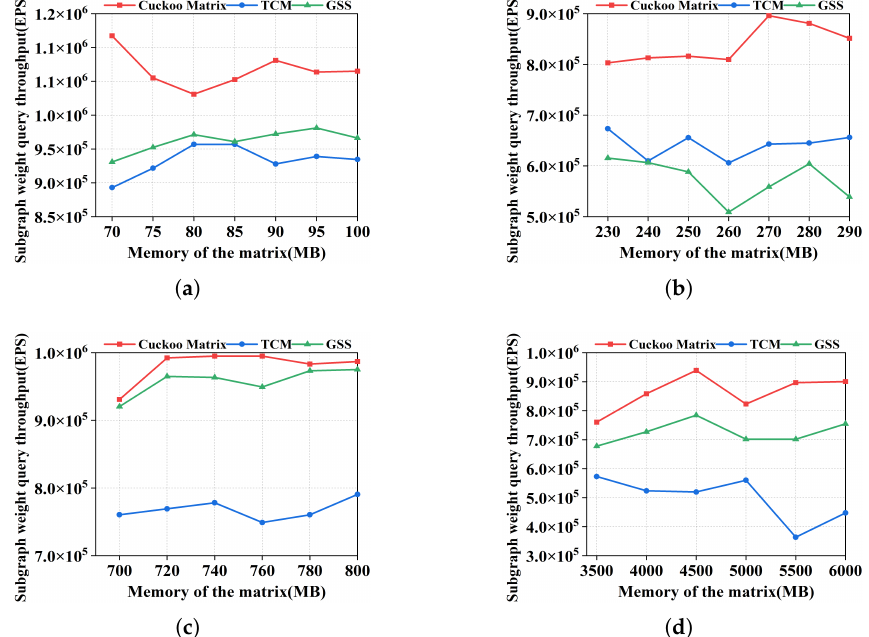
Figure 11. Throughput of subgraph weight queries. ( a ) Skitter. ( b ) DBLP. ( c ) Orkut. ( d ) Wiki.